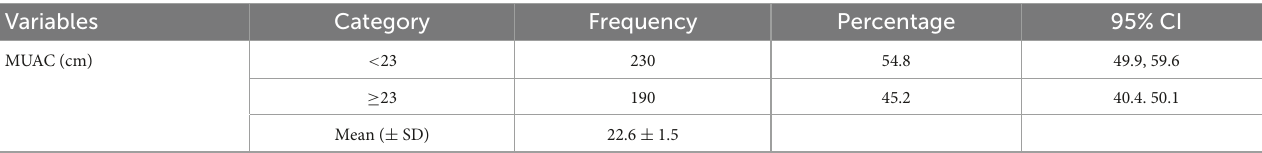
TABLE 4 Nutritional status among lactating mothers in Sekota Internally Displaced Persons (IDP) camps, northern Ethiopia, 2022. Variables